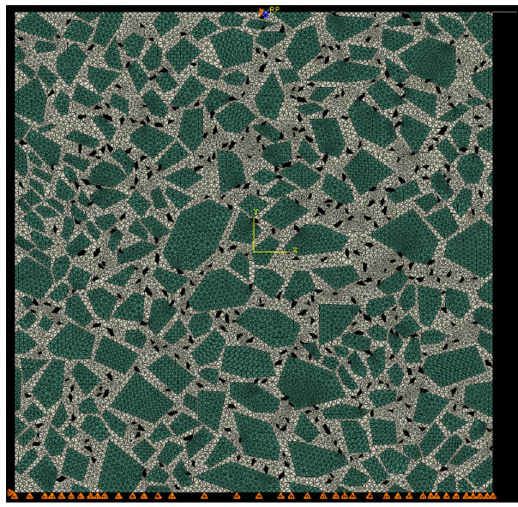
Figure 8. Finite element model of the asphalt mixture.